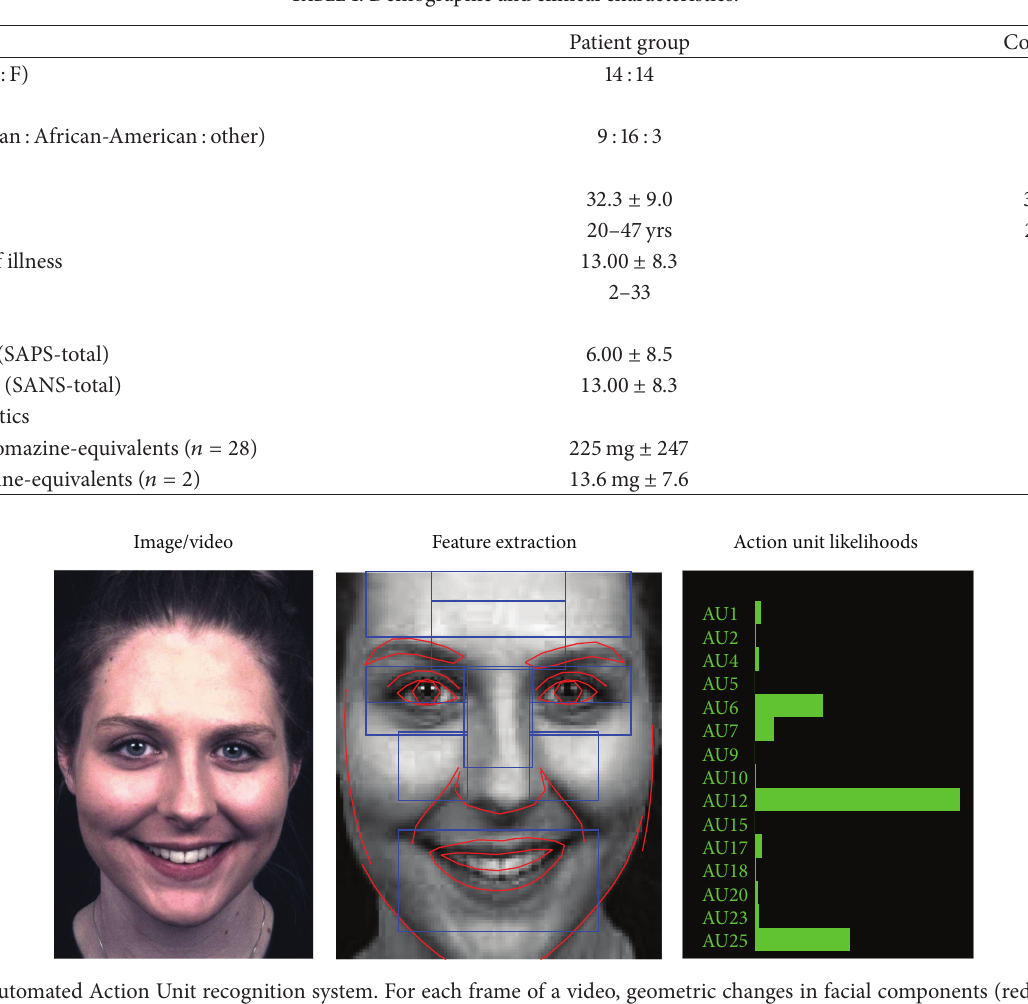
Table 1: Demographic and clinical characteristics.